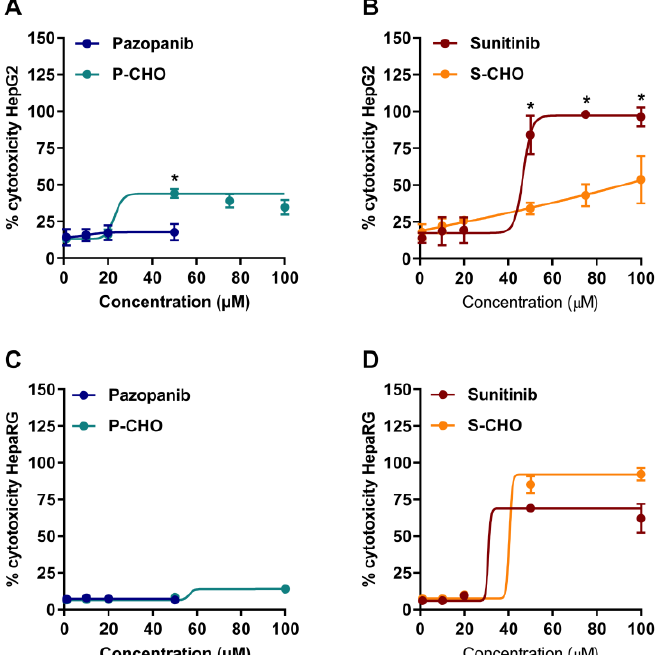
Figure 2. Cytotoxicity on hepatocytes exposed to pazopanib, sunitinib, and their respective aldehydes. Drug cytotoxicity was assessed by measuring lactate dehydrogenase release after 24-h exposure to increasing concentrations of compounds in HepG2 cells ( A , B ) and HepaRG cells ( C , D ). Results are given as mean and standard deviation (s.d.). * p < 0.05 in comparing the parent molecule versus the aldehyde metabolite.